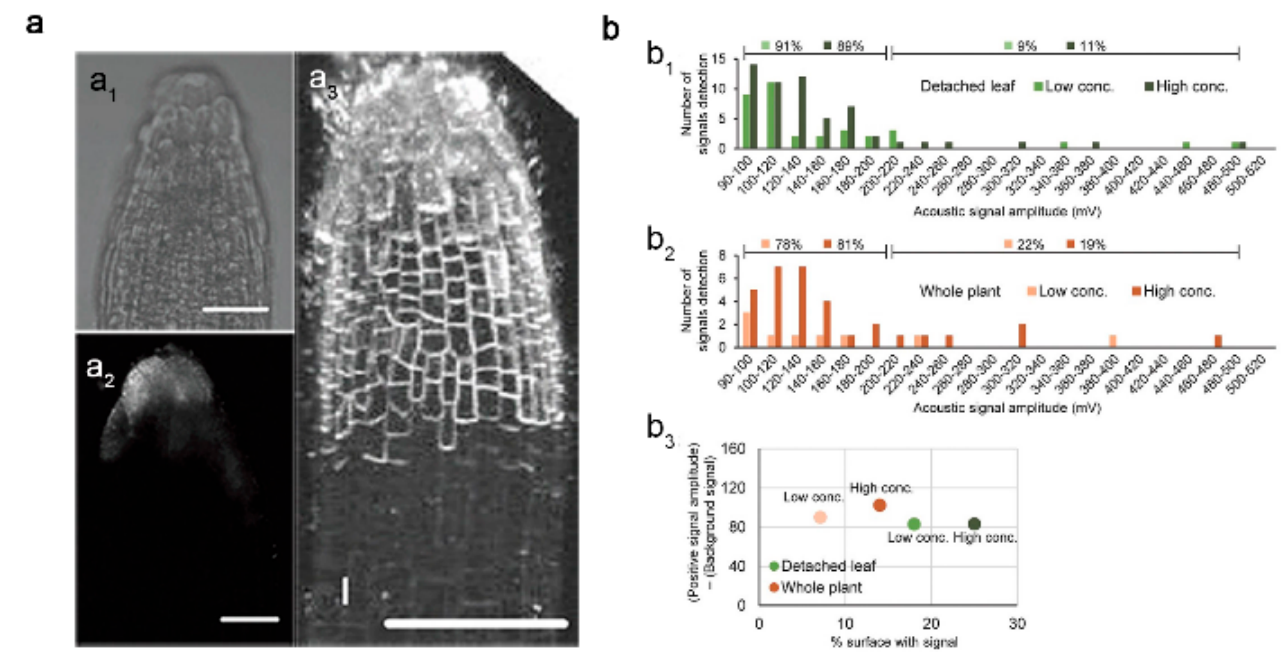
Figure 1. ( a ) Localization of 40 nm silver nanoparticles (Ag NPs) in Arabidopsis roots. ( a 1 ) Two-week- old control root tip demonstrating no Ag NP signal. ( a 2 ) 267.36 mg/L of Ag NPs, 1 week. Ag NPs are shown in the columella cells as an illuminating white crown. ( a 3 ) A surface overview of a brown root tip. ( b ) Statistical analysis of acoustic signals detected from GNPs in Arabidopsis leaves. ( b 1 , b 2 ) The frequency of leaf signal amplitudes is compared between ( b 1 ) high- and low-GNP-concentration exposure to detached leaf petioles and ( b 2 ) high- and low-GNP-concentration exposure to whole plants for two different durations. Signal amplitudes below 200 mV and above 200 mV are indicated on upper side of each graph. ( b 3 ) Percentage of leaf surface that emitted detectable signal (% surface with signal, x axis) and acoustic signal amplitude (average signal amplitude over 90 mV—average signal amplitude below 90 mV, y axis) from ( b 1 ) and ( b 2 ) are plotted. Detached leaf data are shown in green; whole-plant exposure data are shown in orange. Reprinted with permission from Refs. [27,28].